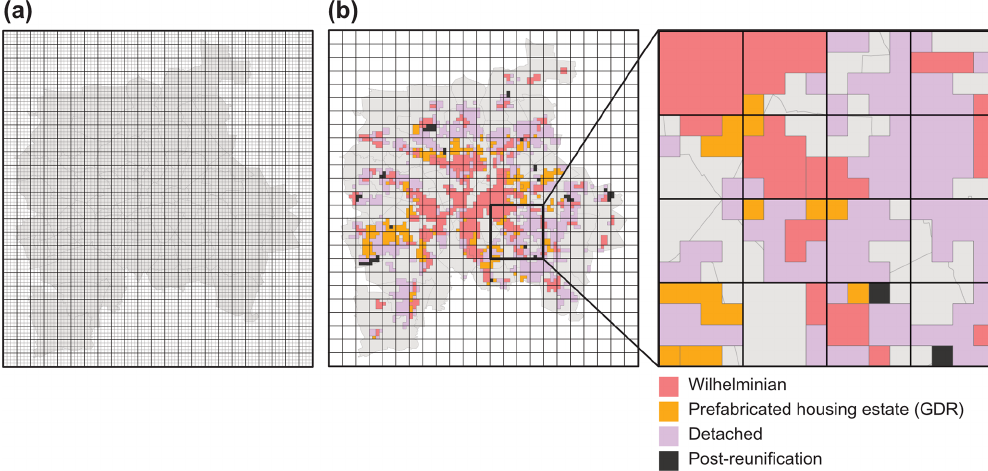
Figure 2. Delineation of spatially homogeneous units (SHUs) based on house types. (a) Study area overlaid with the 1km 2 INSPIRE grid used in the scientific-use file (Boelmann et al., 2019) for geolocating advertised apartments (bold lines) and the 250m × 250m grid used as basis for the delineation of SHU (thin lines); (b) SHU obtained by dissolving the intersection of the 250m × 250m grid and the urban structure and land-use dataset by Haase and Nuissl (2007). As the detail shows, the final size of each SHU may vary considerably, depending on the homogeneity or heterogeneity of urban structure and corresponding predominant house types within each ETRS89-LAEA 1km 2 grid cell. GDR refers to the German Democratic